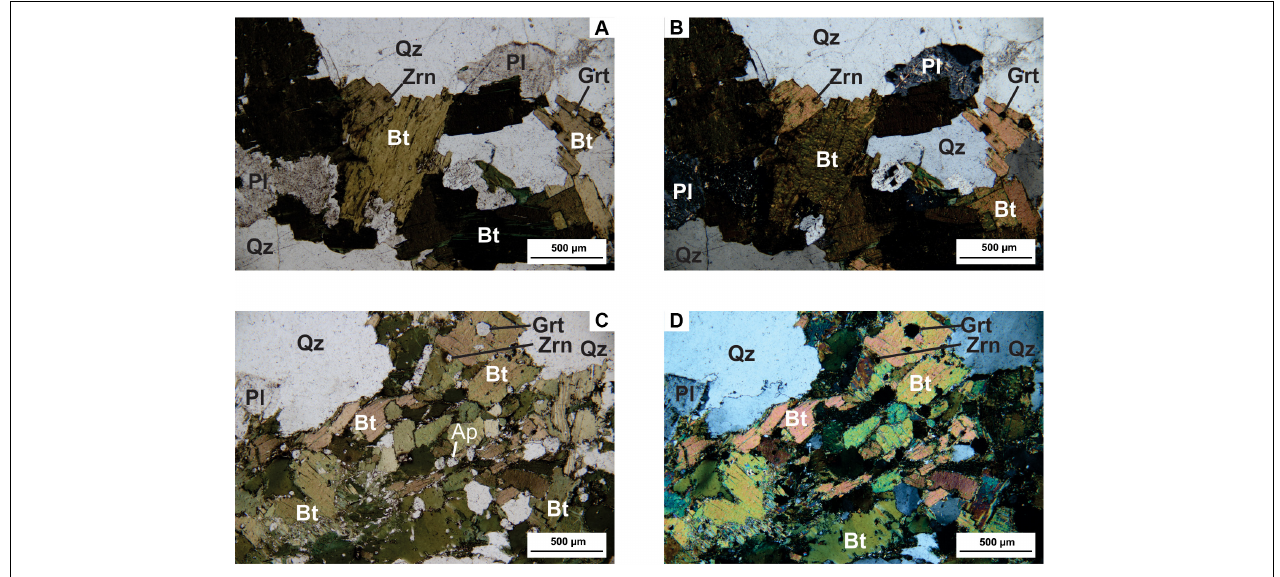
FIGURE 2 | Photomicrograph of the Taipa granite (TP-01) in panel (A) plane polarized light and (B) cross-polars. Photomicrograph of the Coloane granite (CO-03) in panel (C) plane polarized light and (D) cross-polars. Pl, plagioclase; Qz, quartz; Bt, biotite; Grt, garnet; Zrn, zircon; and Ap,